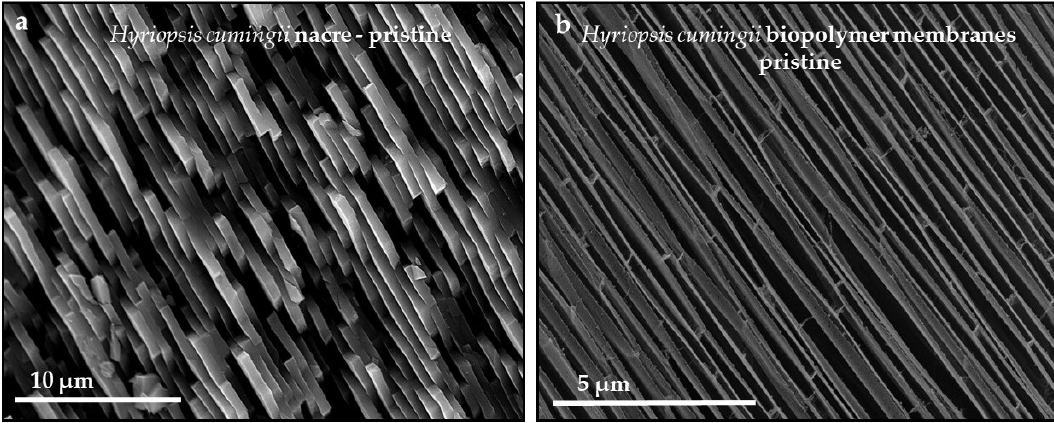
Figure A5. FE-SEM images of nacre tablets ( a ) and biopolymer sheaths ( b ) encasing the tablets.